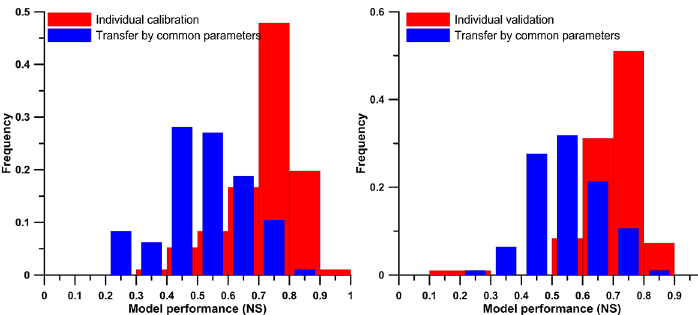
Figure 11. Histograms of the NS model performance of HBV for the 96 test (ungauged) catchments. Left panel: calibration period (1971– 1980), right panel: validation period (1991–2000).